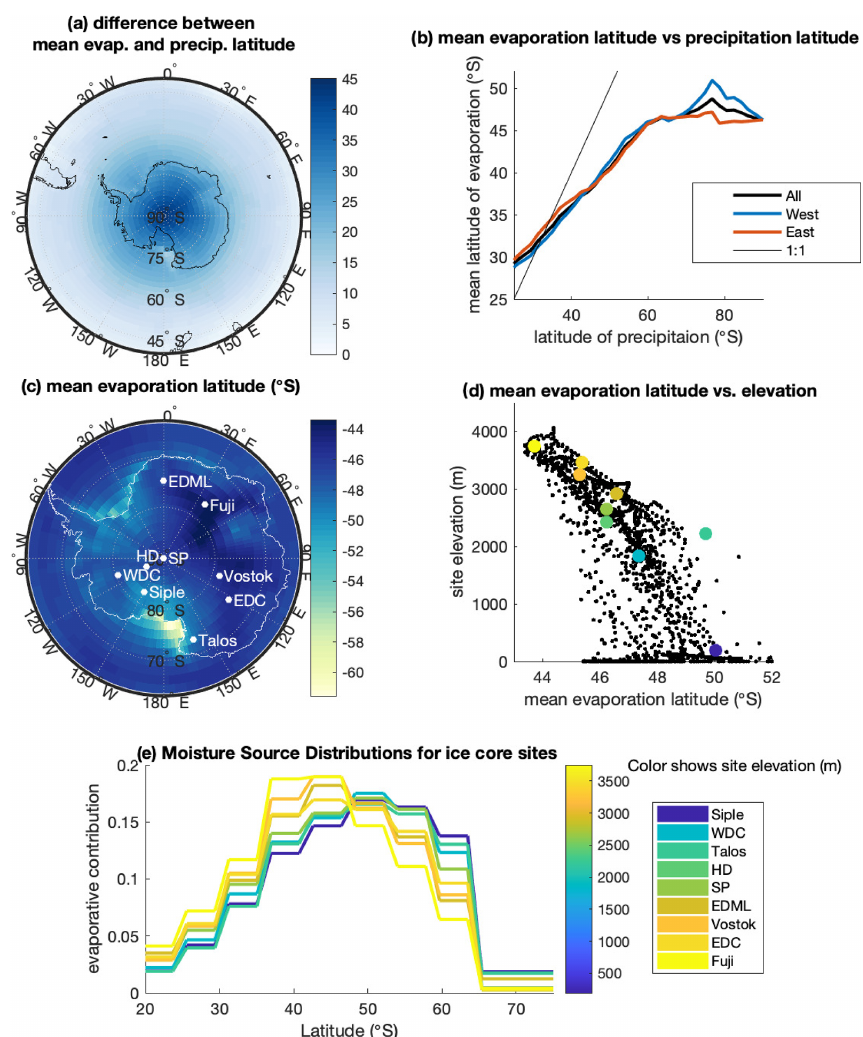
Figure 1. Moisture sources and transport to Antarctica from the moisture-tagged Community Atmosphere Model (CAM) experiment (Markle et al., 2017). (a) Difference, in degrees latitude, between the latitude of precipitation and mean latitude of evaporation (effectively mean transport in degrees of latitude to any site). (b) Mean latitude of evaporation vs. latitude of precipitation. All longitudes are shown by the black line; longitudes encompassing West Antarctica are shown by the blue line, while longitudes encompassing East Antarctica are shown in red. (c) The mean evaporation latitude (in ◦ S) of precipitation falling at all Antarctic grid points. Select ice-core sites shown in white. (d) The relationship between mean evaporation latitude and site elevation across Antarctica. Select ice-core locations shown in color; see text for site details. (e) Latitudinal moisture source distributions for select Antarctic ice-core sites, colored by site